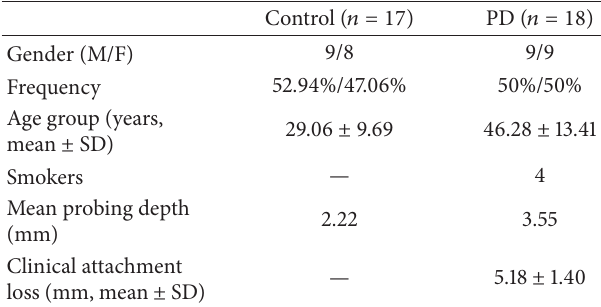
Table 1: Clinical profile of subjects from periodontal disease (PD) and